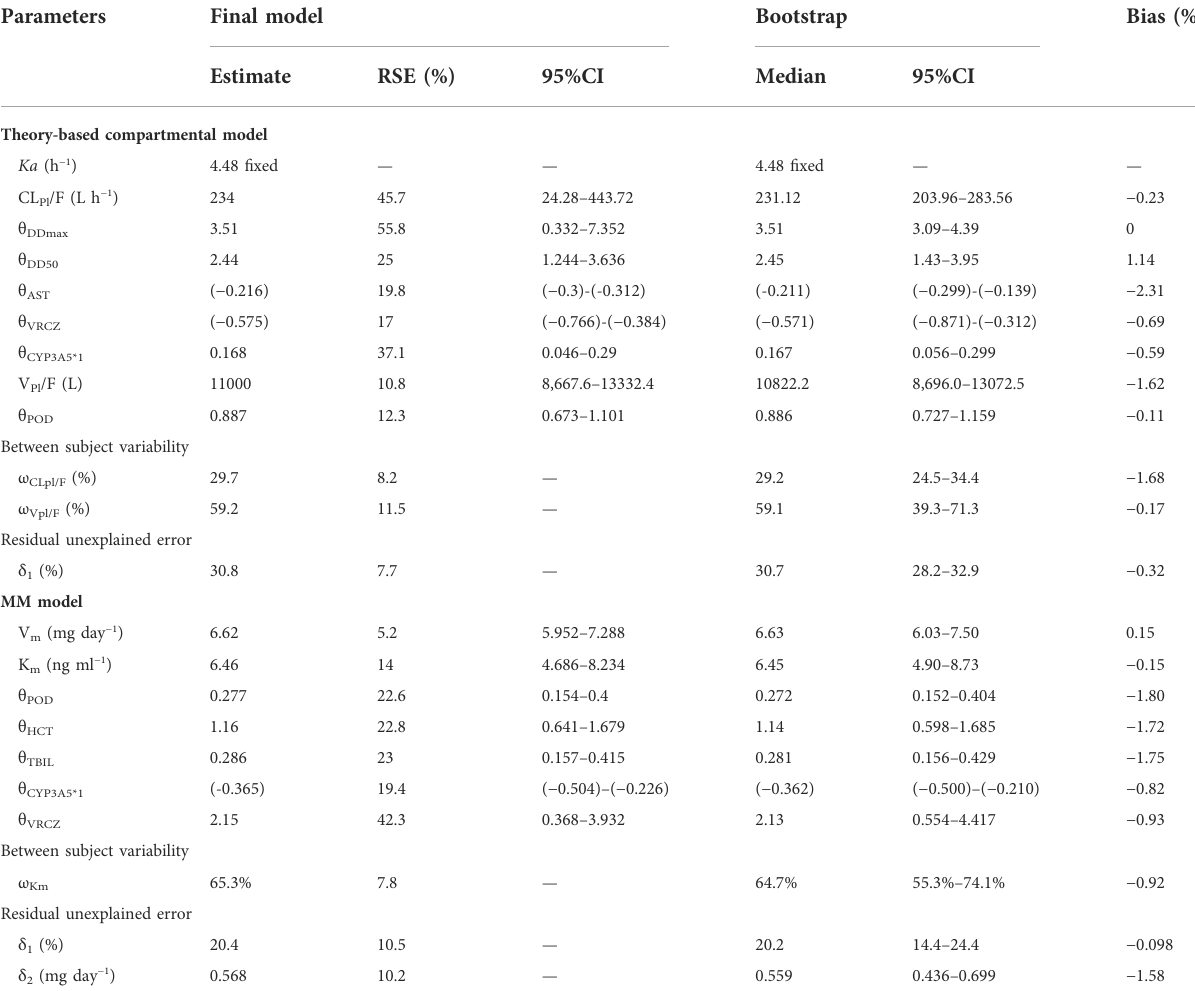
TABLE 4 Pharmacokinetic parameter estimates for the fi nal models and Bootstrap